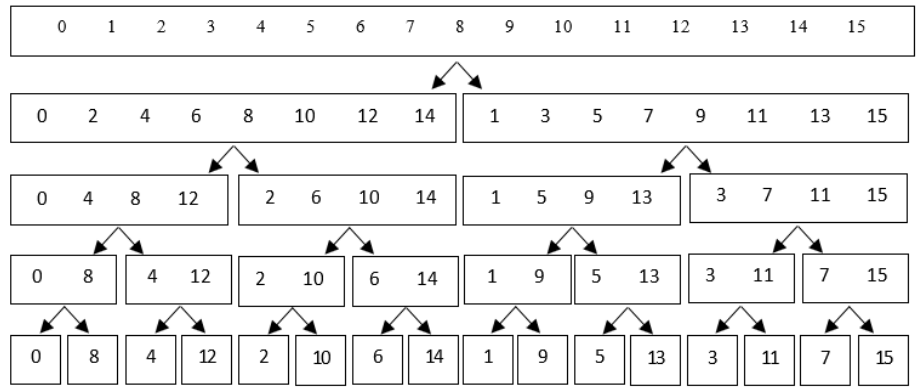
Figure 2. Vector reordering for the Fast Fourier Transform (FFT) algorithm.